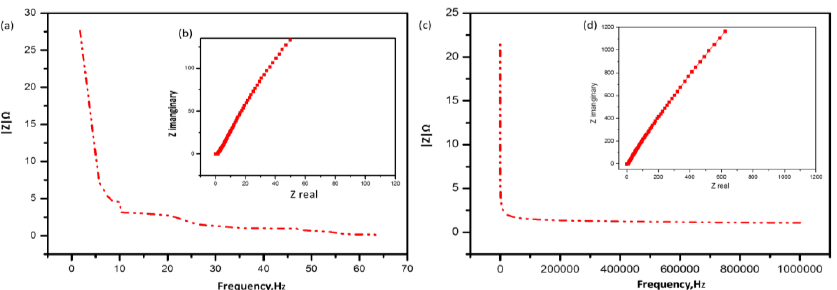
Figure 8. ( a , c ) Nyquist plots and ( b , d ) Bode plot of the conductive Alginate/PEDOT:PSS hydrogel electrolytes.